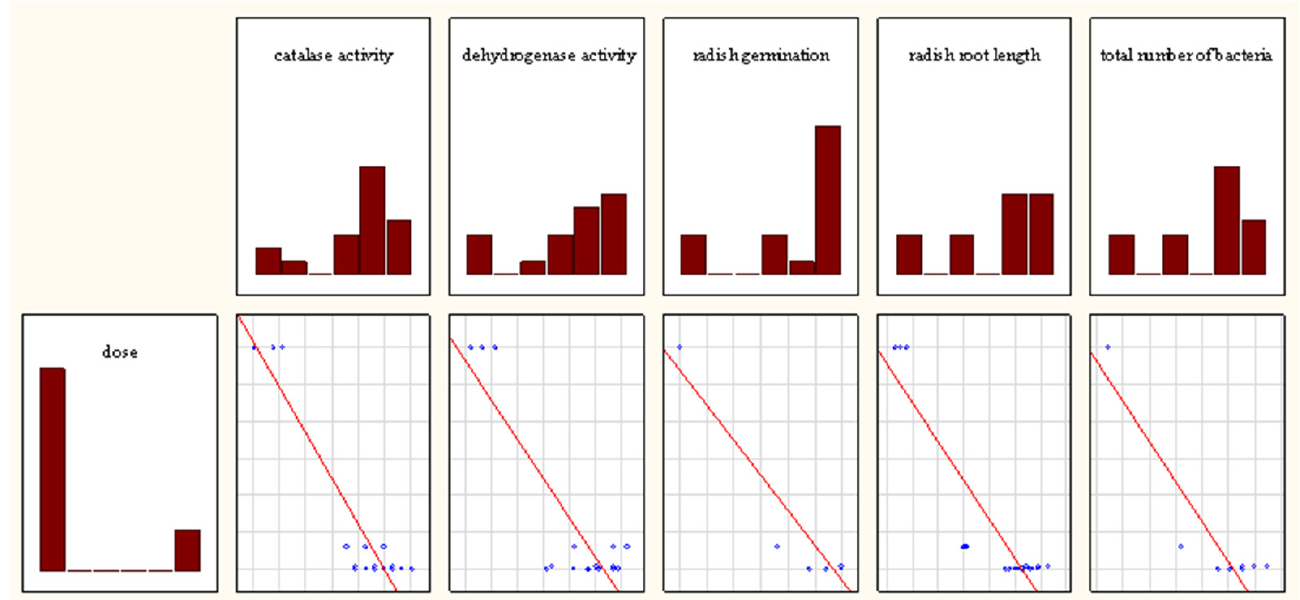
Figure 5. Correlation between biological indicators and concentrations of PtNPs in soil.